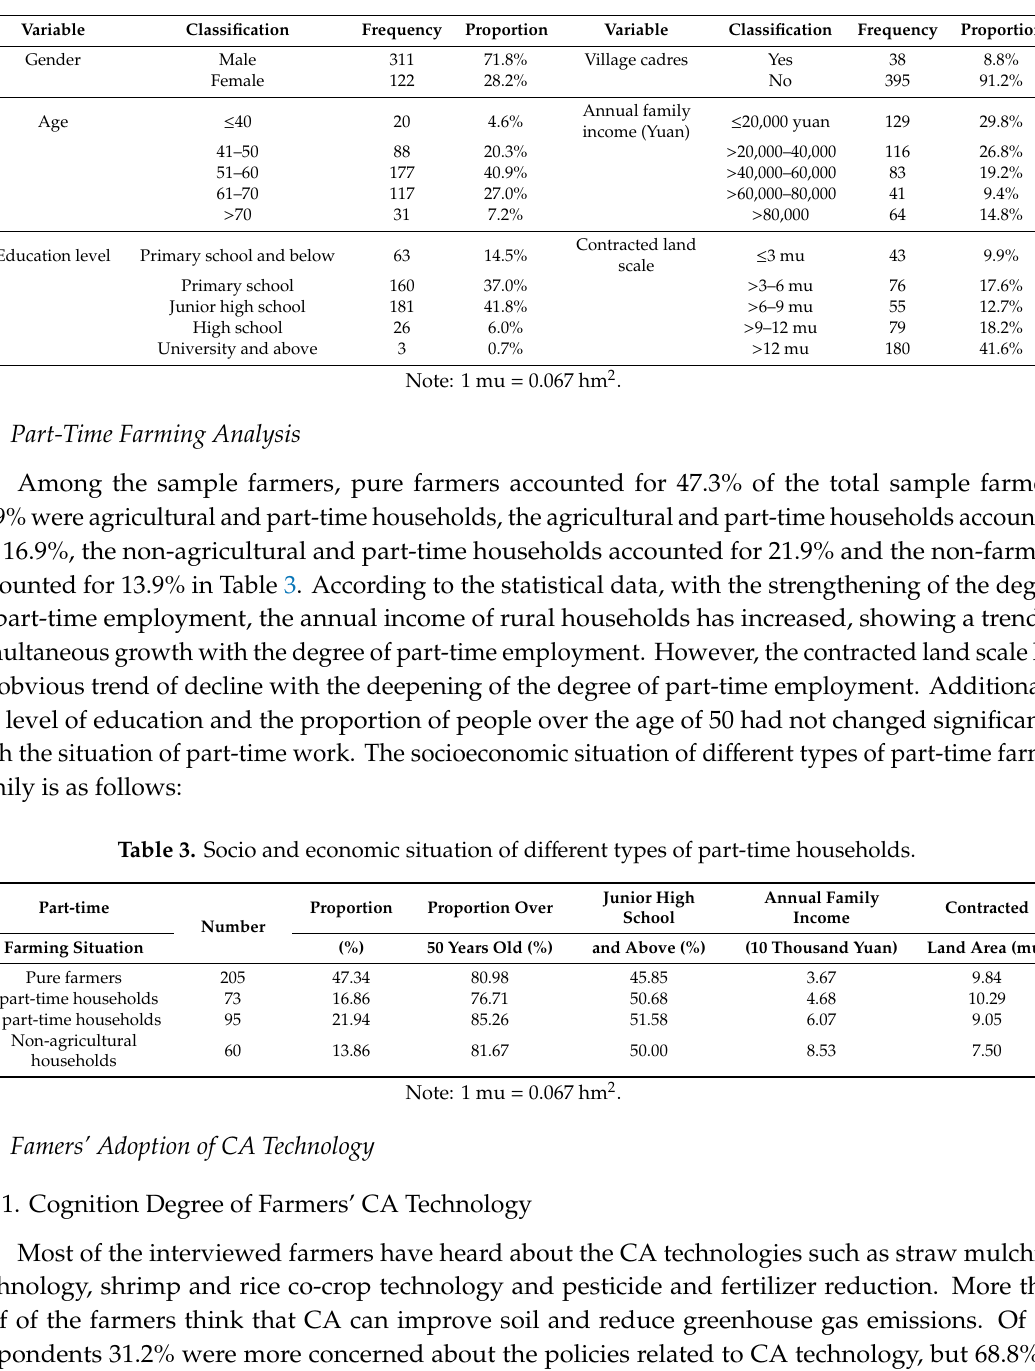
Table 2. Basic social and economic conditions of the interviewed farmers.